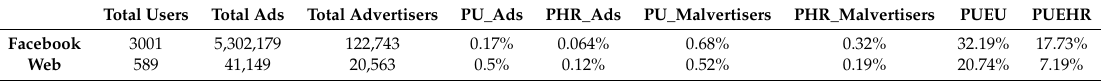
regular Websites (websites dataset): (i) total number of users, (ii) total number of ads in the dataset, (iii) total number of advertisers, (iv) percentage unsafe ads (PU_Ads), (v) percentage highly risky ads (PHR_Ads), (vi) percentage of malvertisers (P_malvertisers), (vii) percentage of highly risky malvertisers (PHR_malvertisers), (viii) percentage of users exposed to unsafe ads (PUEU) ads, and (ix) percentage of users exposed to highly risky ads (PUEHR).